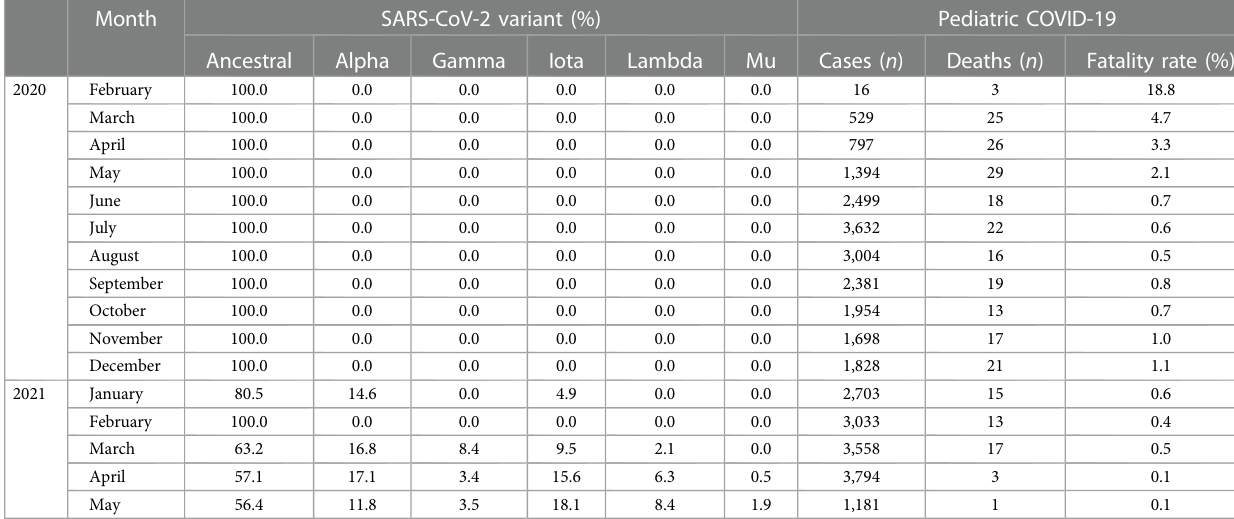
TABLE 6 SARS-CoV-2 variants circulating in Ecuador from 2020 to May